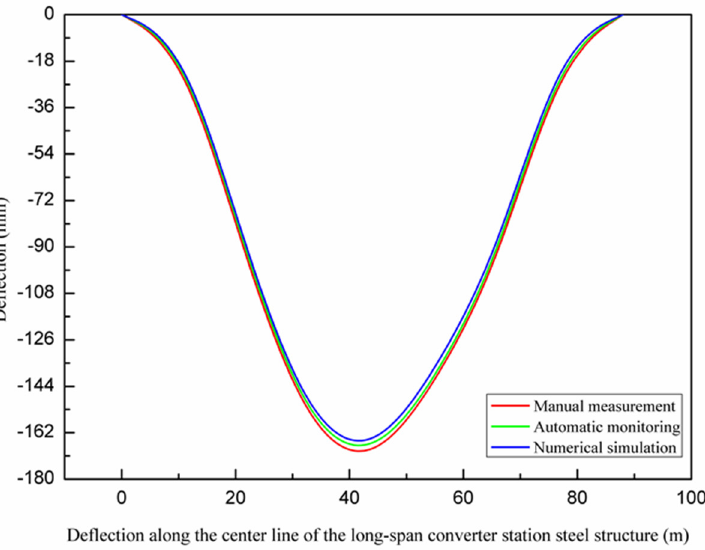
. Figure 17. Deflection along the center line of the long − span converter station steel structure.